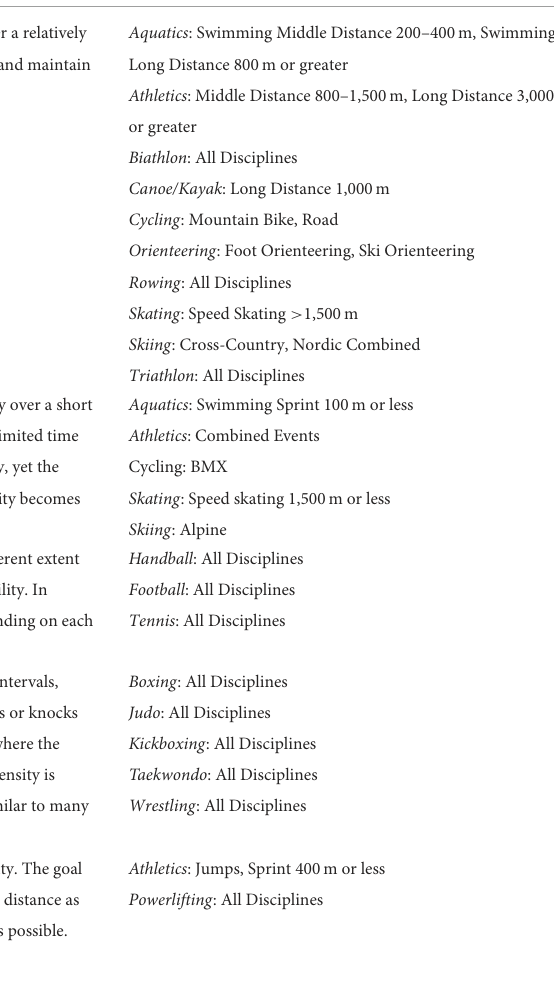
TABLE 1 Categorization of sport disciplines included in Anti-Doping Norway’s hematological ABP program in the period 2010–2019 based on physiological characteristics. Physiological Physiological characteristic(s) classification group VO 2max